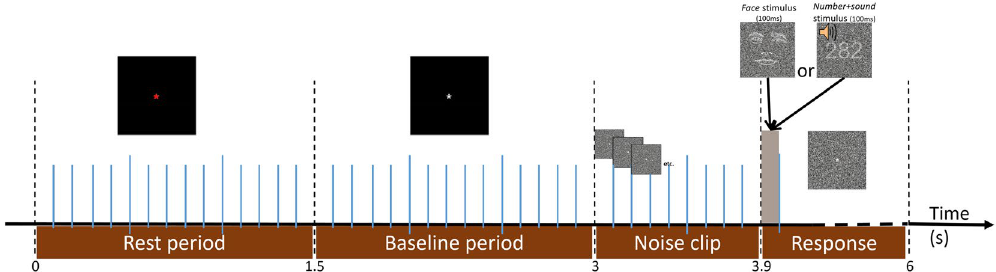
Figure 6. Timeline of a single trial. Each trial is preceded by a rest period, followed by a baseline period (necessary for EEG processing, not reported here), each lasting 1.5 s. A noise clip consisting of 9 random-dot frames of 100 ms each indicates the arrival of the stimulus in a non-stimulus-specific fashion. The stimulus then appears on a noisy visual background for 100 ms. The same noisy background frame then lasts until the participant’s response and times out after 2 s otherwise.